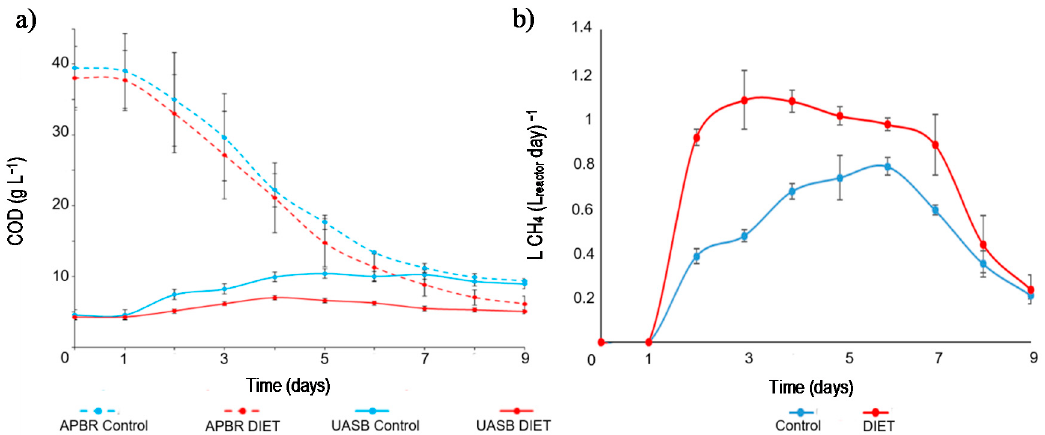
Figure 6. ( a ) COD concentration in APBR control, APBR DIET, UASB control and UASB DIET. ( b ) Methane yield in Control process and DIET process.